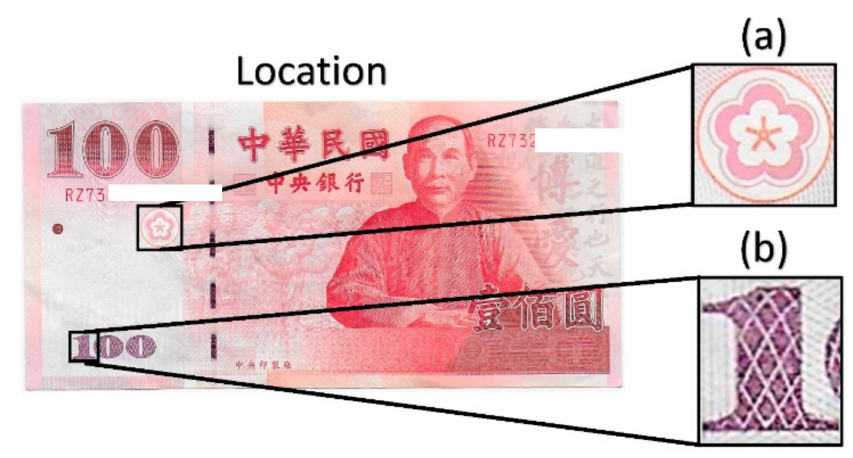
Figure 5. ROI selection: ( a ) cherry blossom symbol and ( b ) Arabic numeral “1”.